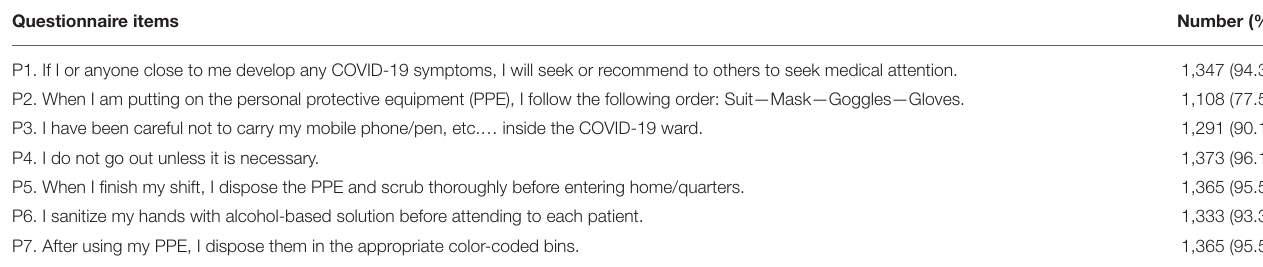
TABLE 4 | Frequency and percentage of the participants who were practicing appropriately based on responses to the questionnaire items. Questionnaire